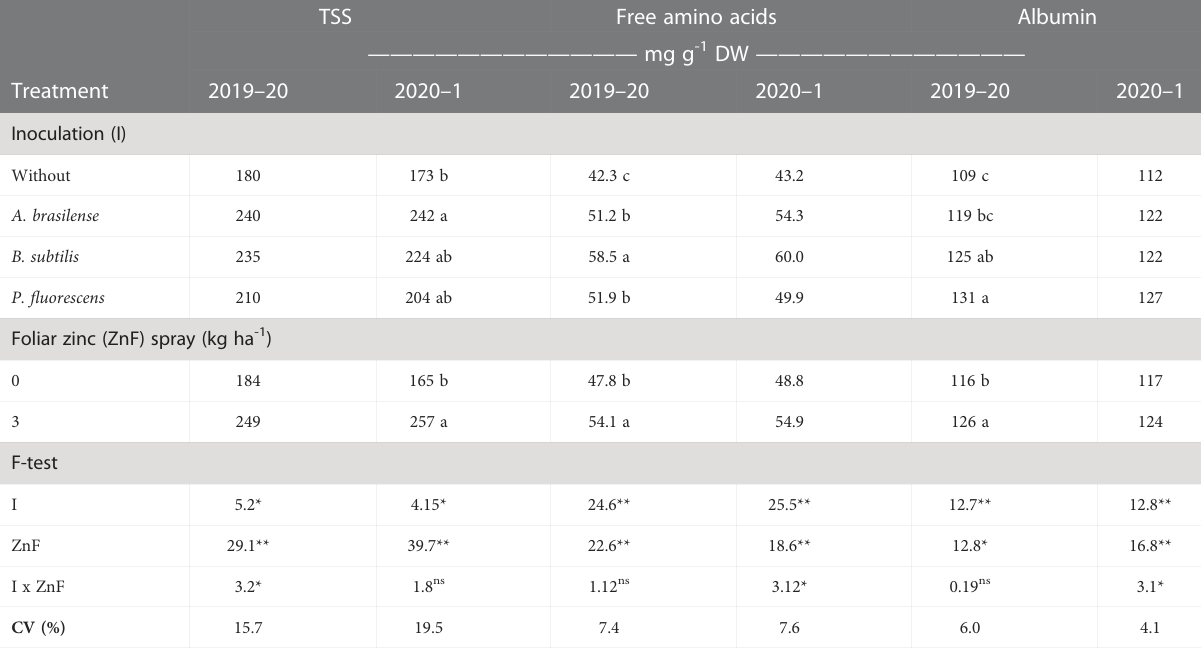
TABLE 6 Total soluble sugar (TSS), free amino acids, and albumin concentration as a function of plant growth-promoting bacteria inoculation, together with or without nano-zinc oxide spray, in the 2019 – 20 and 2020 – 1 cropping seasons.